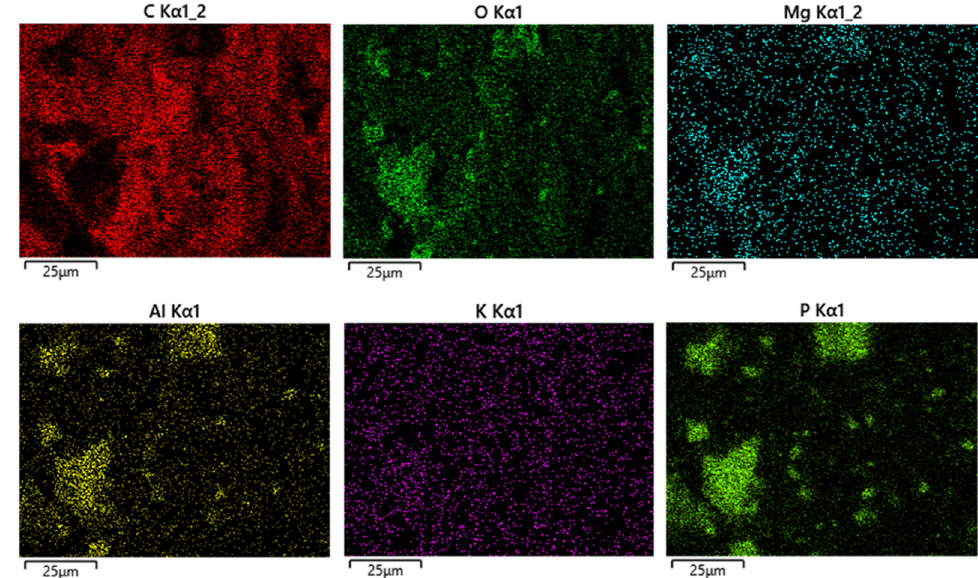
Figure 4. Elemental mapping for Eb150 + 40%G UV-LED cured film.